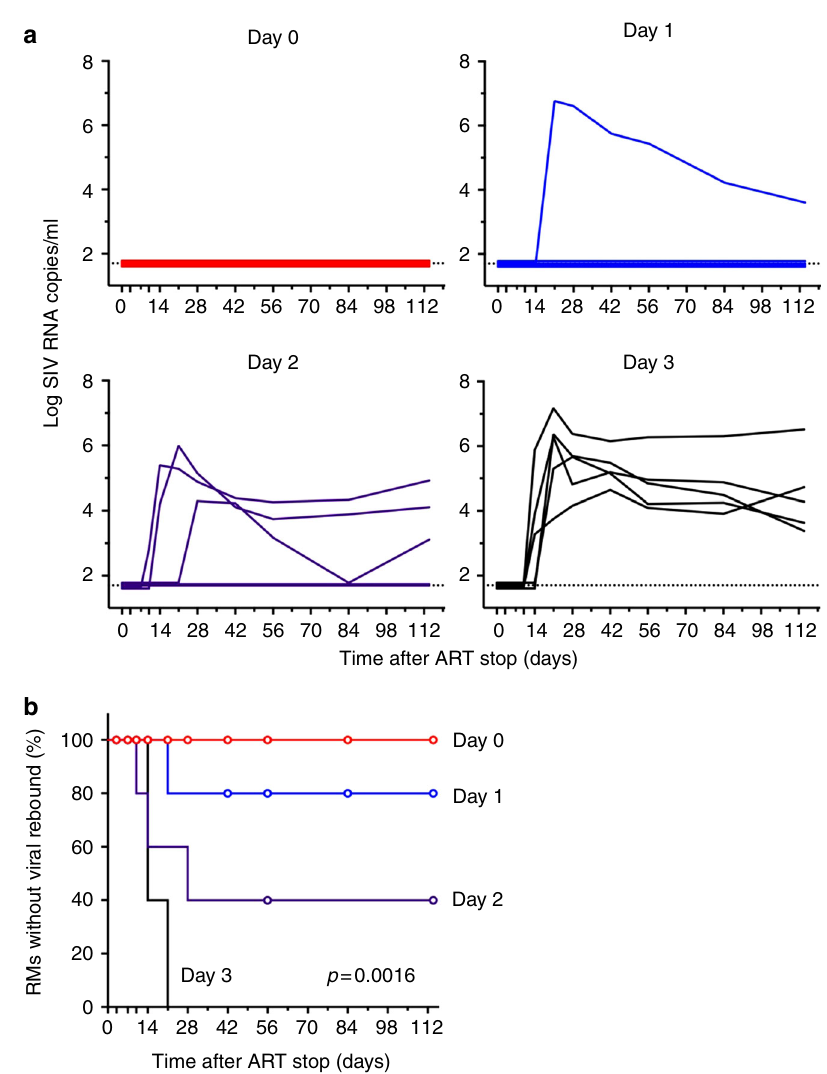
Fig. 5 Viral rebound kinetics following ART discontinuation. a ART was discontinued after 24 weeks, and plasma SIV RNA was assessed on days 0, 3, 7, 10, 14, and then weekly. b Kaplan – Meier curve showing the time to viral rebound for each group of animals. The differences between groups were analyzed by the log-rank test and p value is